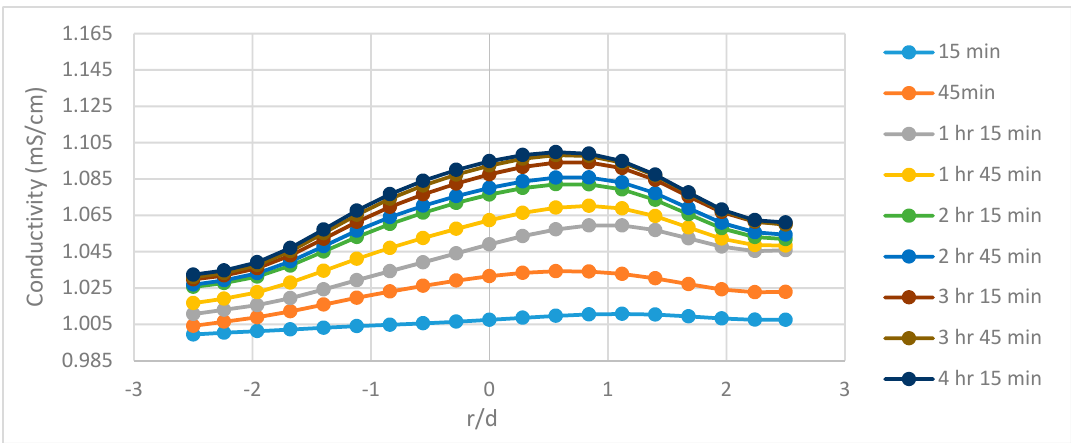
Figure 6. The conductivity profiles for P1 during run no. 1 with no nanoparticles, taking the central horizontal region of the tomograms into account.